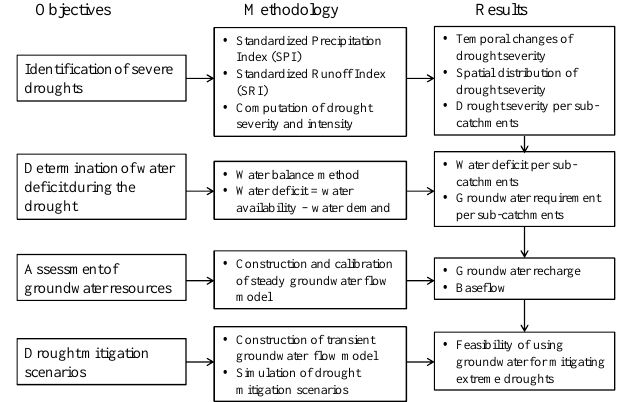
Table 1. List of data sets used.